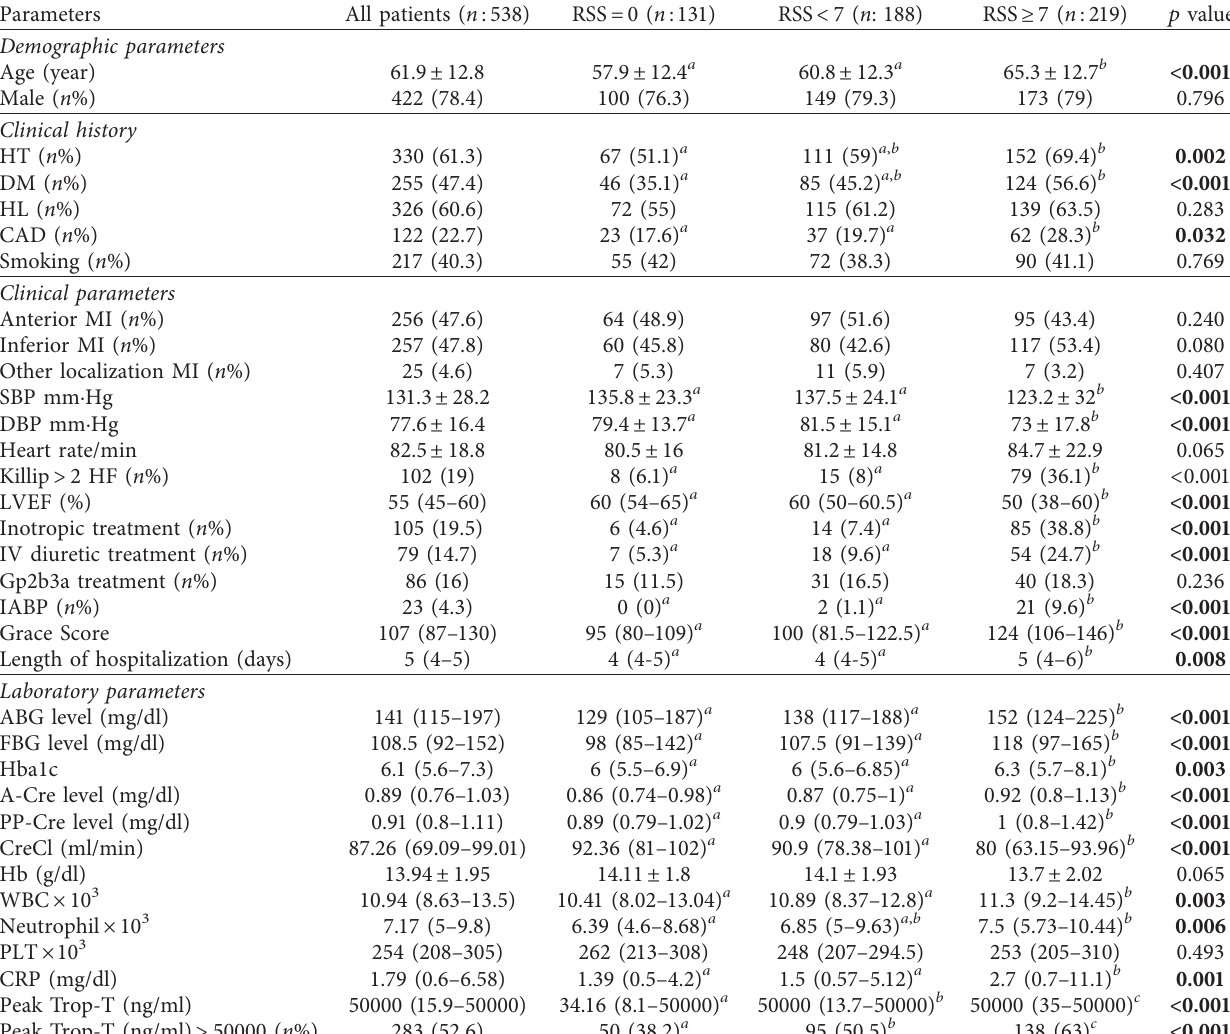
Table 1: In-hospital demographic, clinical, and laboratory characteristics and Grace Scores of patients.